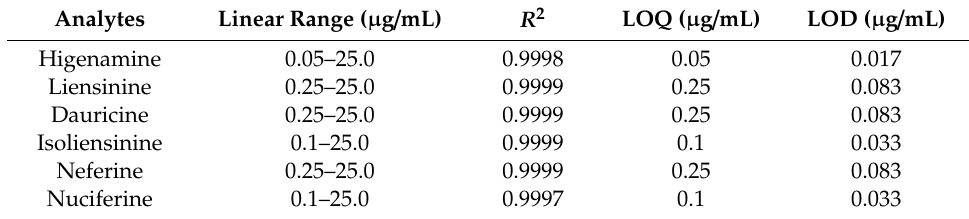
Table 5. Linear range, coe ffi cient of determination, limits of detection, and limits of quantification